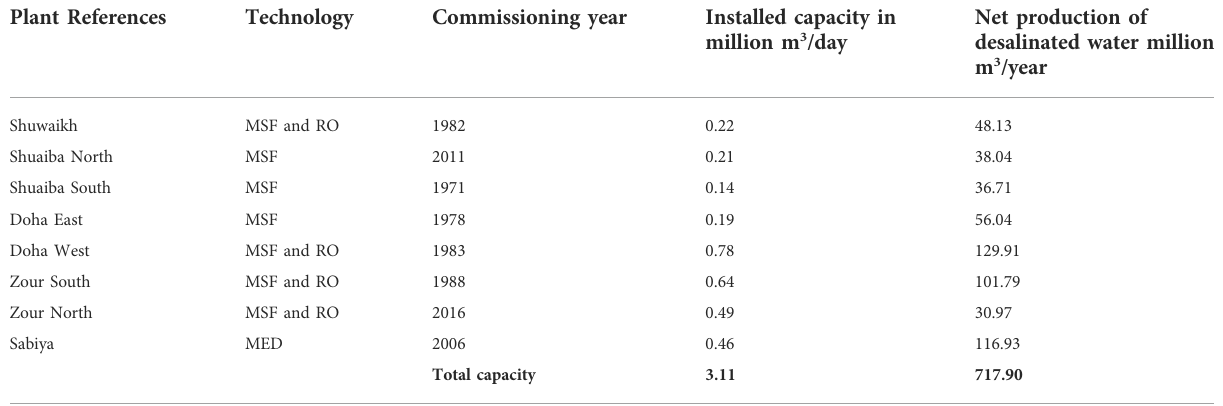
TABLE 2 Desalination plants with mounted capacities (Statistical Yearbook Water In Kuwait,